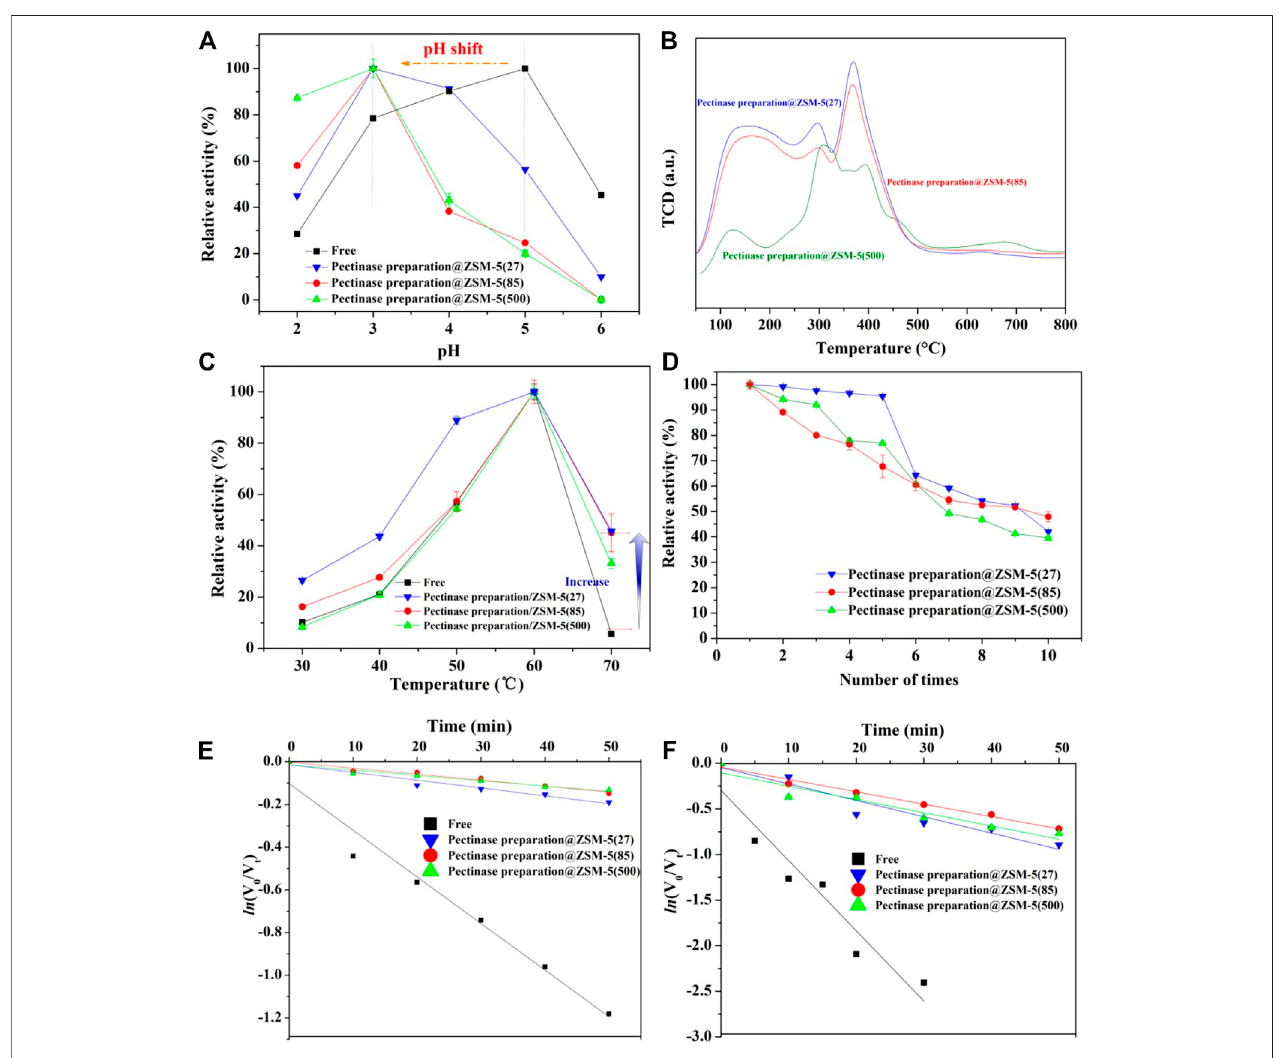
FIGURE 3 | Evaluation of hydrolysis performance of pectinase preparation@ZSM-5. (A) Effect of pH of the reaction medium on the hydrolytic activity of pectinase preparation@ZSM-5 catalysts and free pectinase preparation. (B) NH 3 -TPD pro fi les of pectinase preparation@ZSM-5 catalysts. (C) Effect of reaction medium temperature on the hydrolytic activity of pectinase preparation@ZSM-5 catalysts and free pectinase preparation. (D) Reusability of pectinase preparation@ZSM-5 catalysts. (E,F) First-order thermal deactivation plots of pectinase preparation@ZSM-5 catalysts and free pectinase preparation at (E) 60 ° C and (F) 65 ° C.